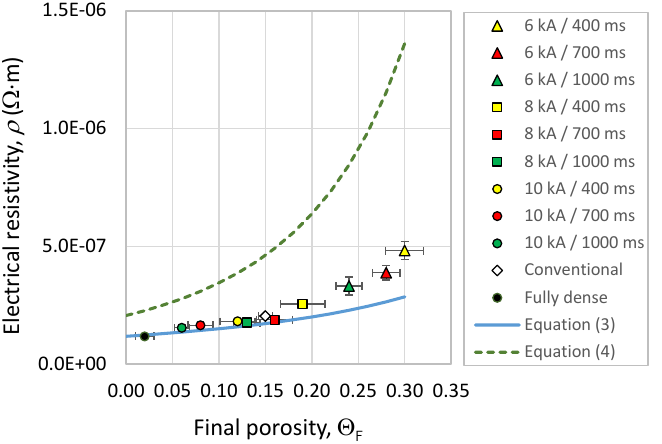
Figure 9. Electrical resistivity ( ρ ) vs. final porosity ( Θ F ) for the MF-ERS compacts, conventional compact and fully dense sample. The theoretical models given by Equations (3) and (4) are also repre- sented.